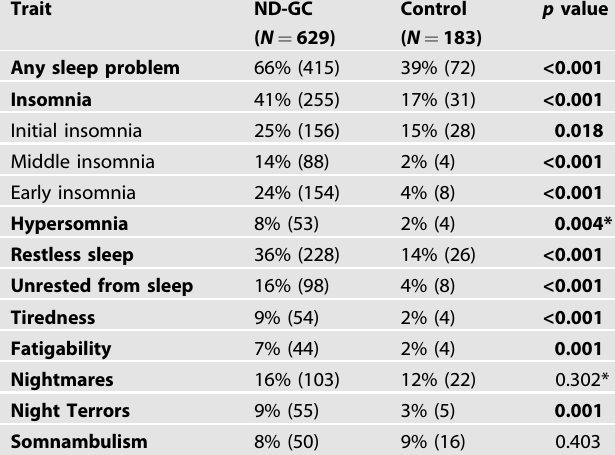
Table 1. Sleep symptomatology in children with an ND-GC and control